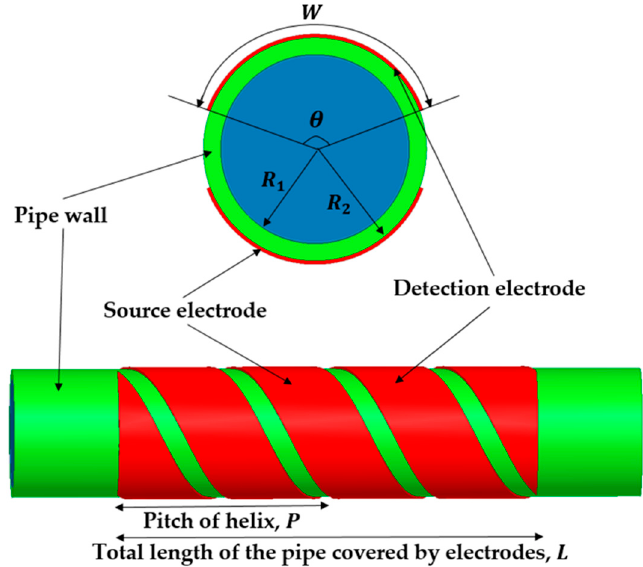
Figure 1. The structure of 360° twisted helical capacitance sensor design in 2D and 3D